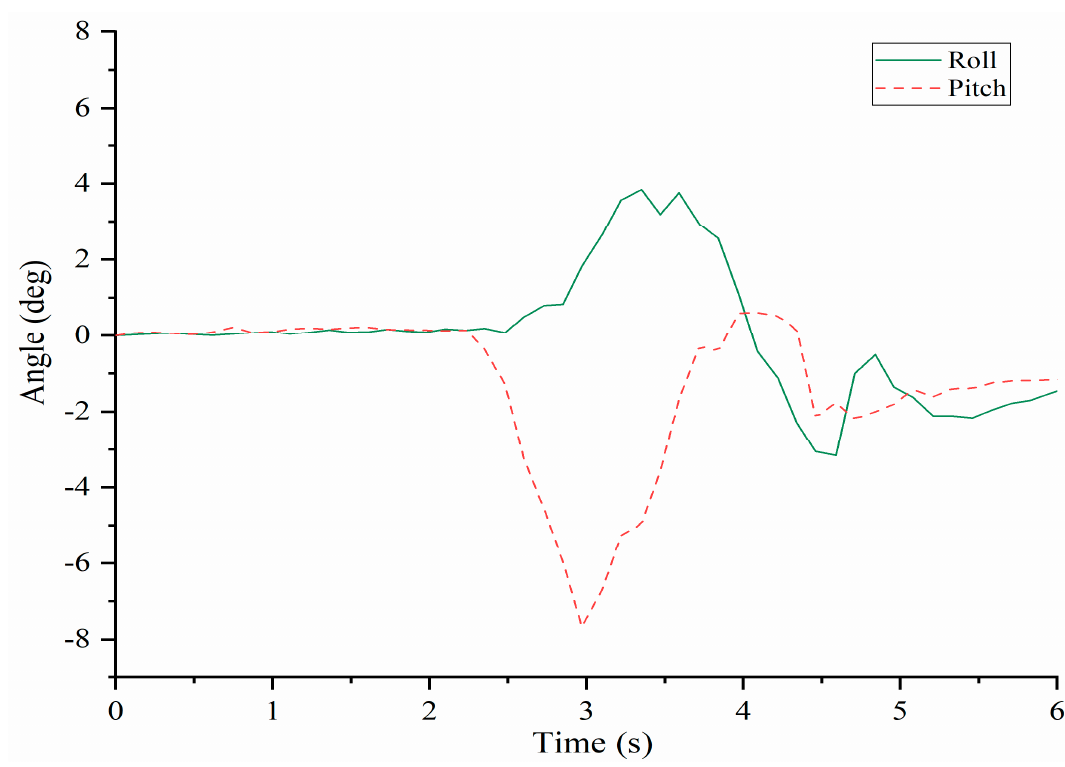
Figure 10. Rolland pitch angles of the shoulder body during full rotation, Table 2.